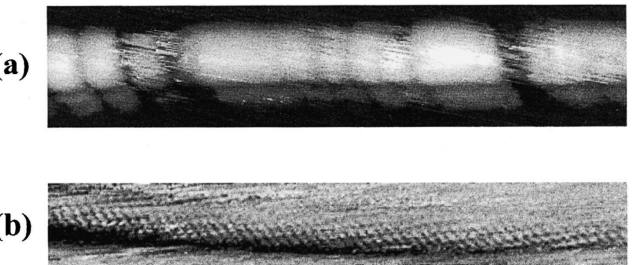
Figure 3. STM images of a SWCNT ( a ) after fluorination at 250 ◦ C for 12 h. The bright regions correspond to sections on the tube covered by fluorine atoms. ( b ) A pristine single-walled carbon nanotube was deposited on an Au (111) surface grown on mica substrate and imaged with a C60-functionalized STM tip. The image is high-pass filtered Reprinted with permission from Ref. [46]. Copyright 2002 Elsevier.